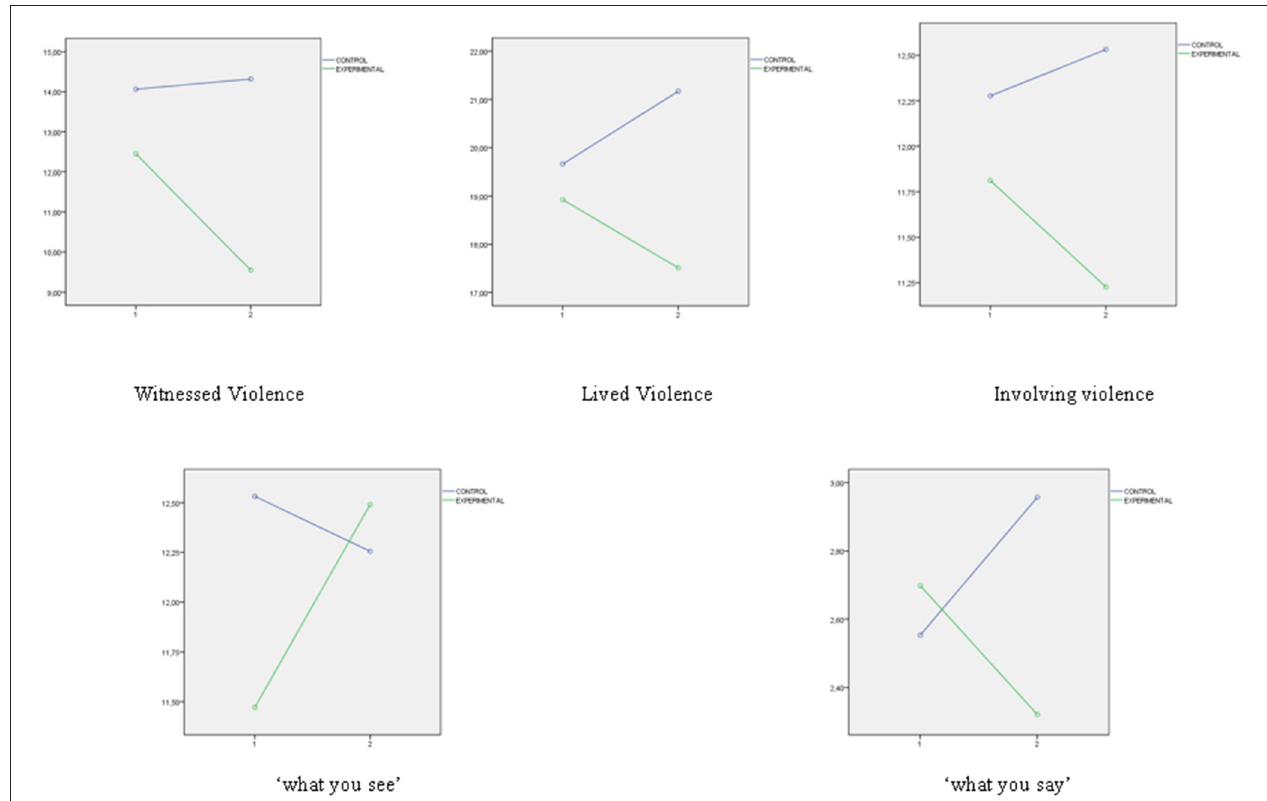
FIGURE 1 | School violence after the educational intervention measure with school violence in preschool and primary school